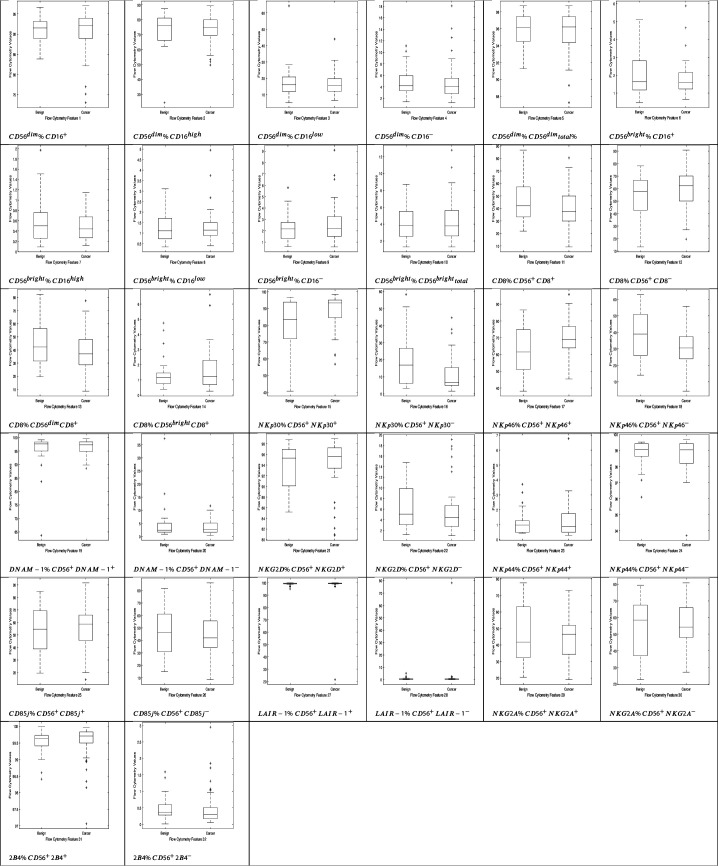
NK cell phenotypic features in men with benign prostate disease and patients with prostate cancer.Boxplots represent the flow cytometry values of each feature for patients with benign disease and with prostate cancer.